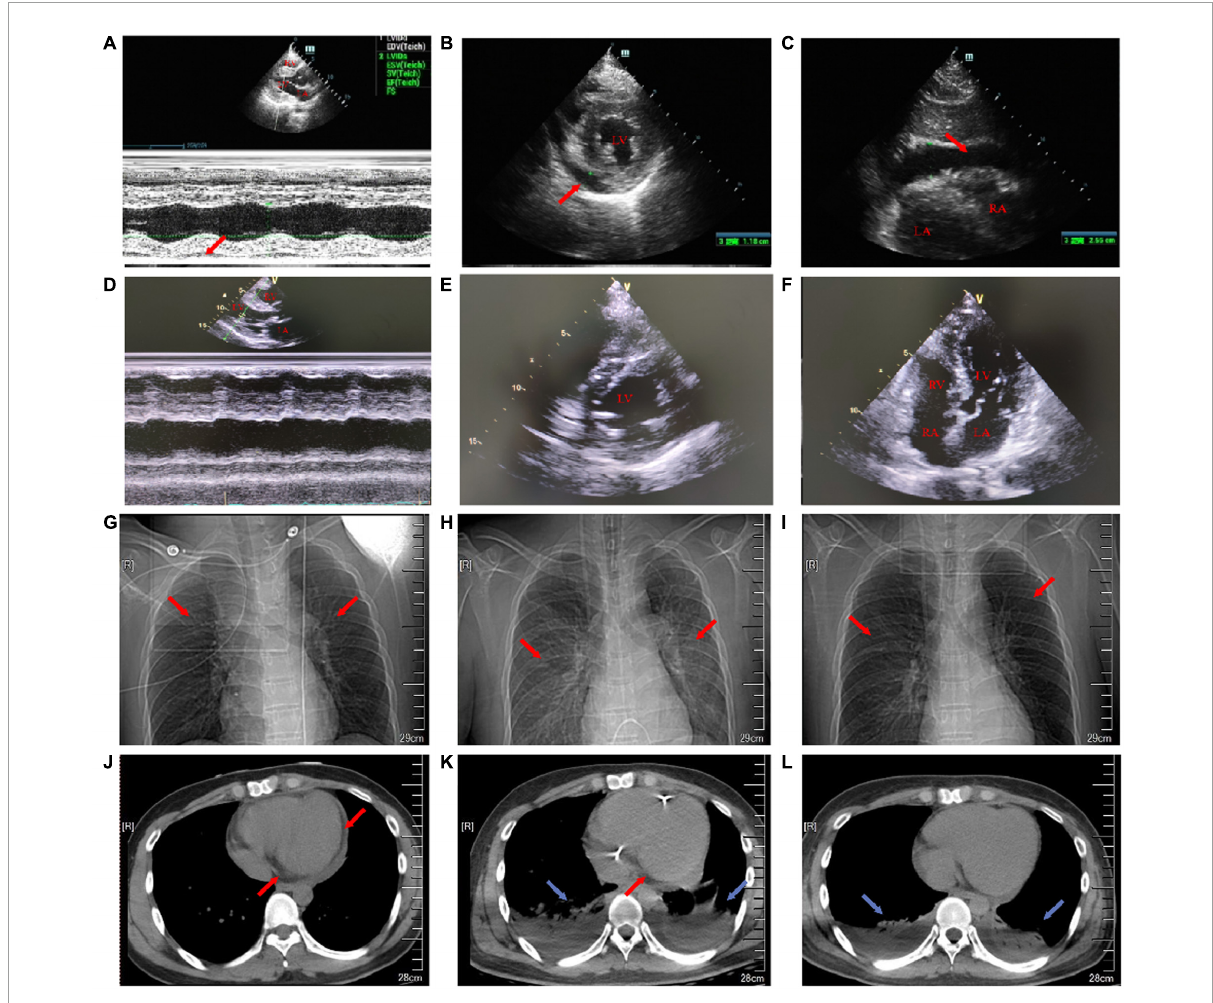
FIGURE2 Transthoracic echocardiography on the first day and the 18th day of admission. Chest X-ray and chest CT images on the first, eighth, and 15th day of admission. (A) On the first day of admission, the maximum anterior–posterior diameter of the posterior dark area of the left ventricular posterior wall on the long-axis view of transthoracic echocardiography was 0.8 cm (red arrow). (B) On the first day of admission, the maximum anterior–posterior diameter of the dark area of the lower wall of the left ventricle on the short-axis view of transthoracic echocardiography was 1.2 cm (red arrow). (C) On the first day of admission, transthoracic echocardiography showed that the anterior–posterior diameter of the dark area under the xiphoid process was 2.5 cm (red arrow). (D) On the 18th day after admission, the pericardial effusion on the long-axis view of transthoracic echocardiography was less than that before. (E) On the 18th day after admission, the pericardial effusion on the short-axis view of transthoracic echocardiography was less than that before. (F) On the 18th day of admission, transthoracic echocardiography